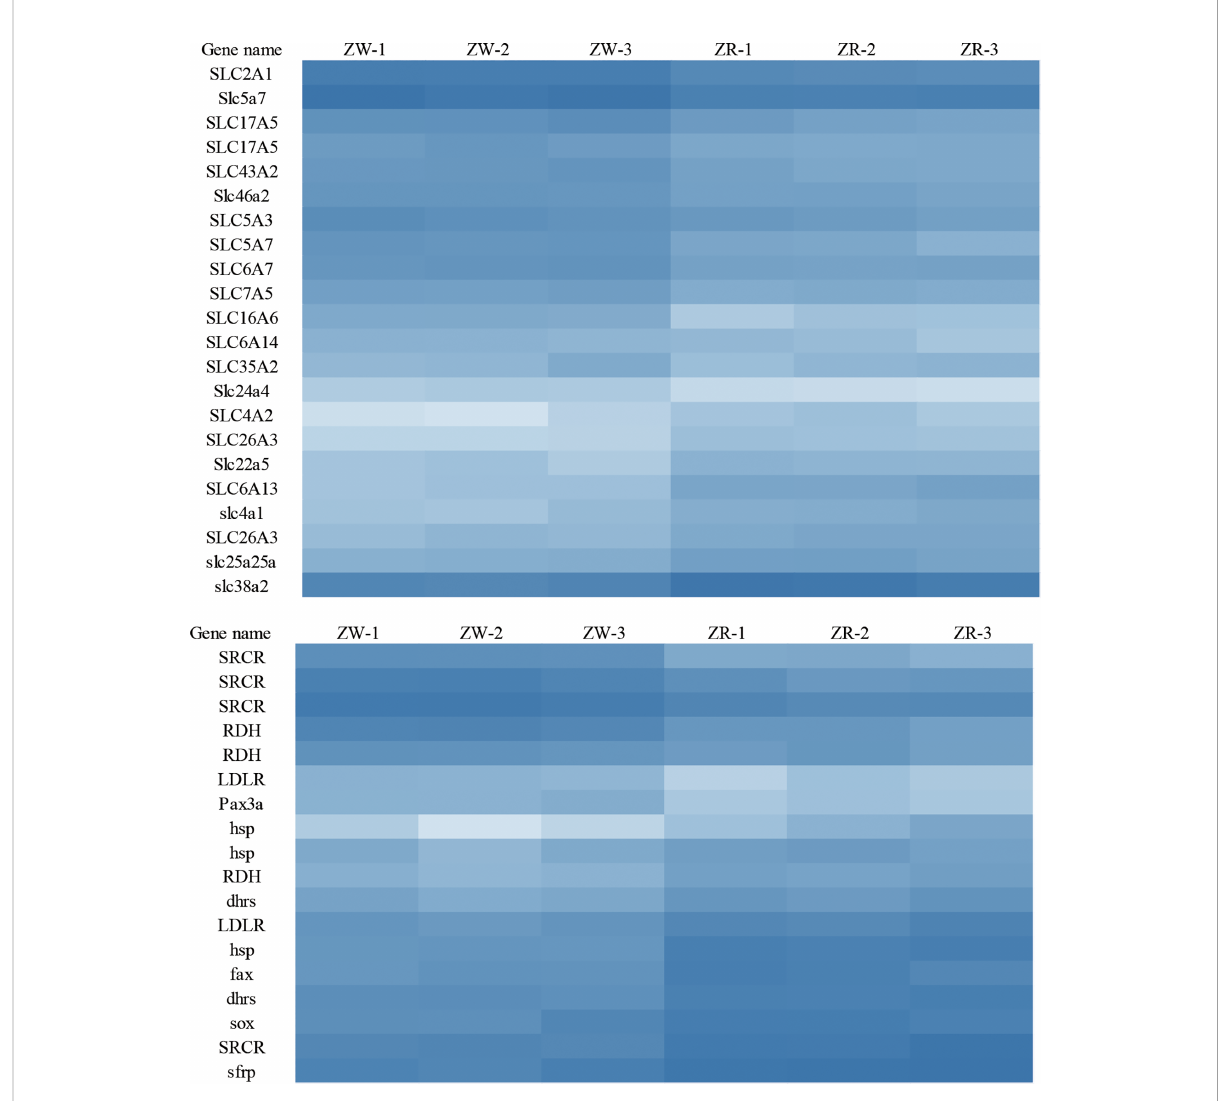
FIGURE 1 DEGs related to carotenoid uptake, transport, and accumulation. ZW represents the brown group, and ZR represents the red